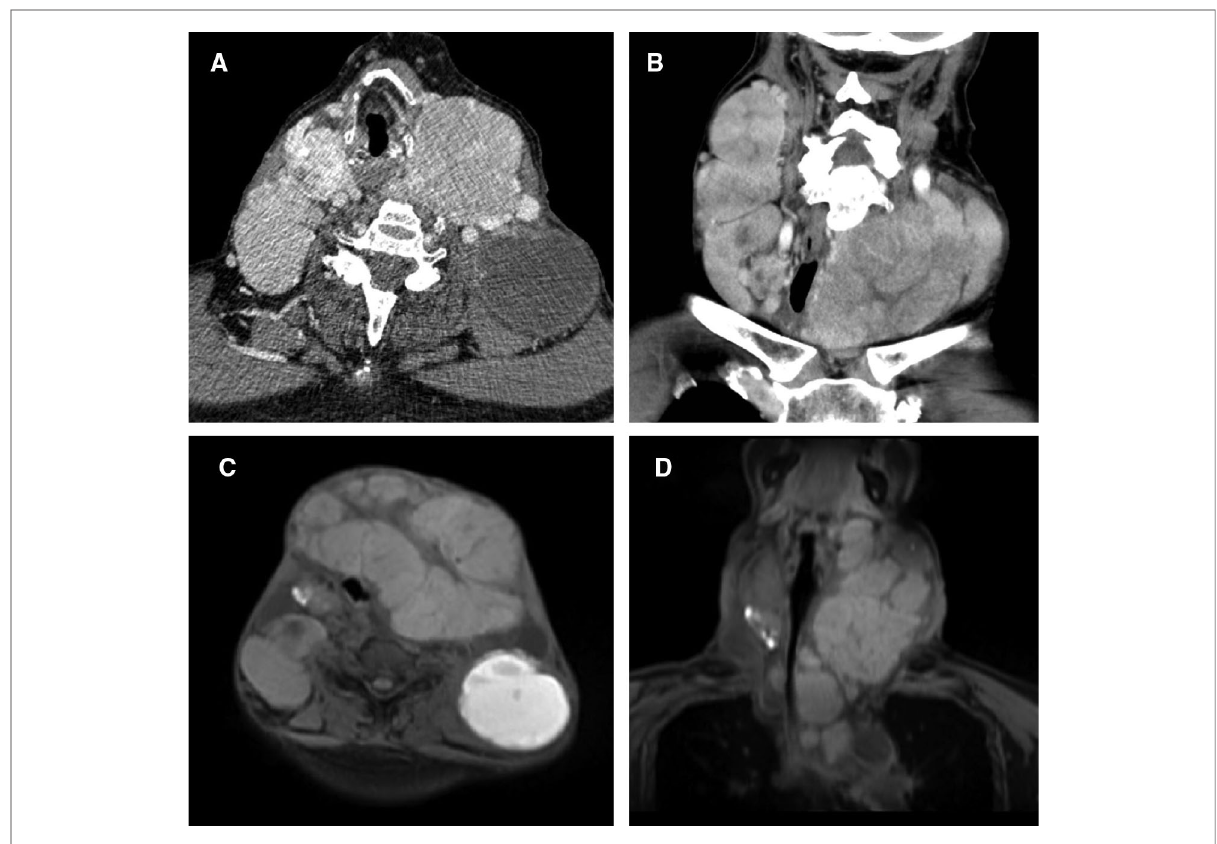
FIGURE 2 CT and MR images of the neck. ( A ) Transverse and ( B ) coronal sections of the neck revealed swelled thyroid with multiple enlarged cervical lymph nodes on CT. ( C ) Transverse and ( D ) coronal sections of the neck revealed swelled thyroid with multiple enlarged cervical lymph nodes on MR, causing the tracheal compression and